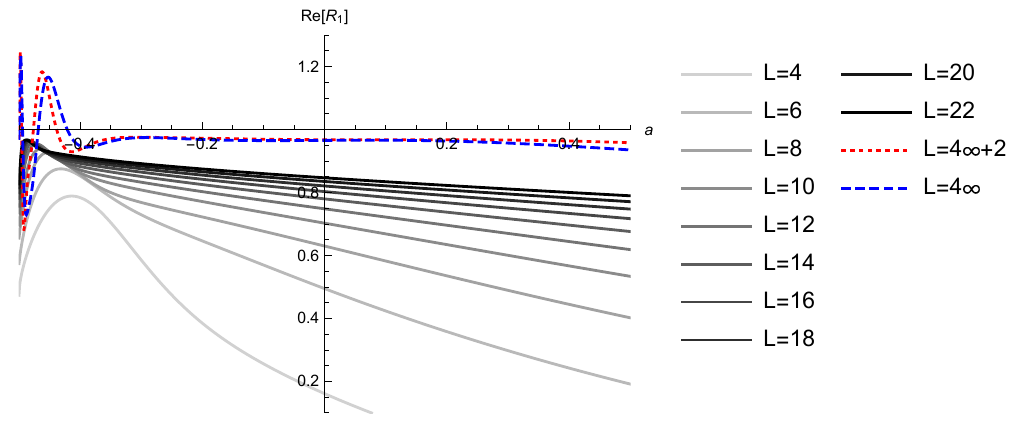
at the truncation level L . The dotted and a